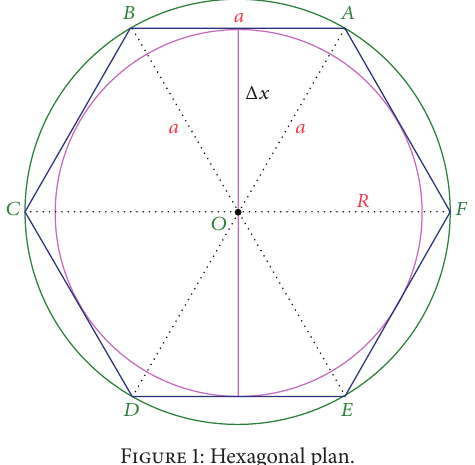
Figure 1: Hexagonal